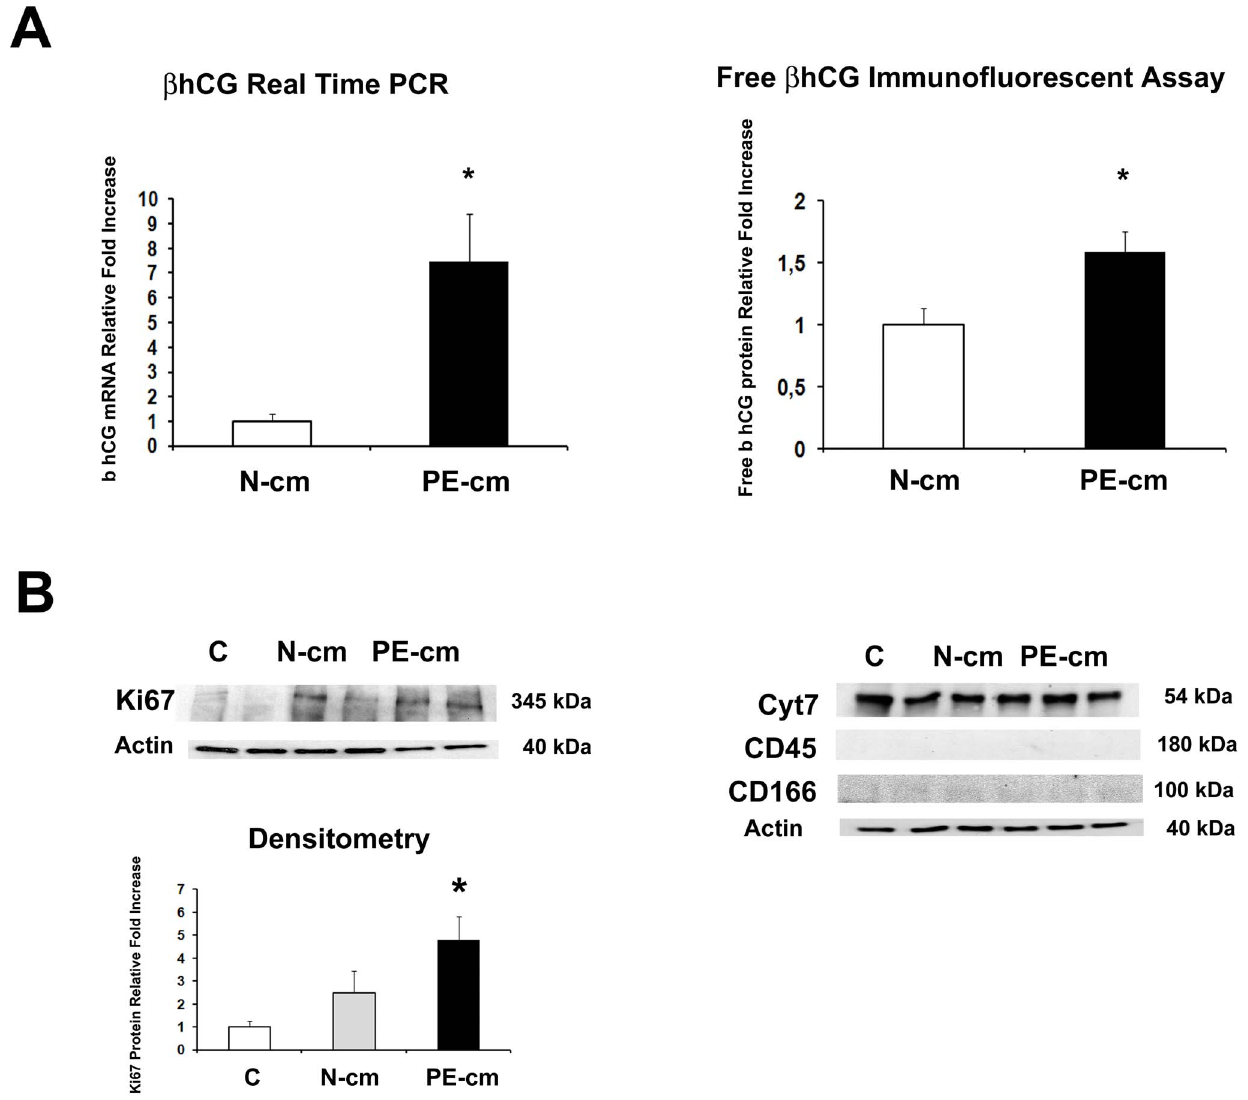
Figure 5. b hCG and Ki 67 expression in physiological placental villous explants treated by normal or PE PDMSCs conditioned media. A) b hCG mRNA (left panel) and free b hCG protein (right panel) levels in physiological villous explants treated with unconditioned [C], normal [N-cm] or preeclamptic [PE-cm] PDMSC conditioned media; B) Ki67 protein expression levels (left panel) in villous explants treated under the above mentioned experimental conditions. Figure B-right panel shows representative Western Blots for the characterization of villous explants cellular components: Cyt7 (trophoblast cell marker), CD45 (haematopoietic/endothelial cell marker) and CD166 (mesenchymal stromal cells marker). Statistical significance (*) has been considered as p , 0.05.